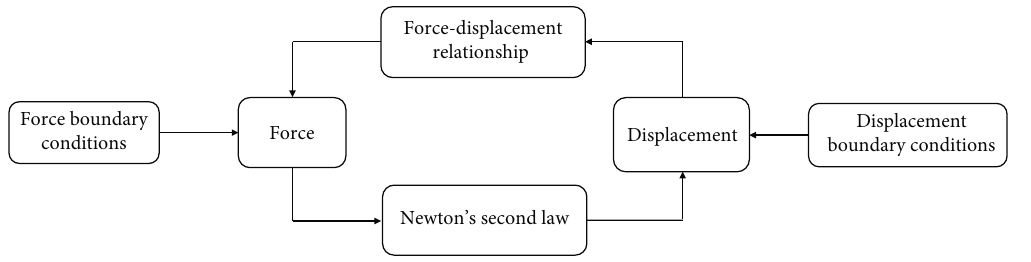
Figure 7: Schematic diagram of PFC iterative process.